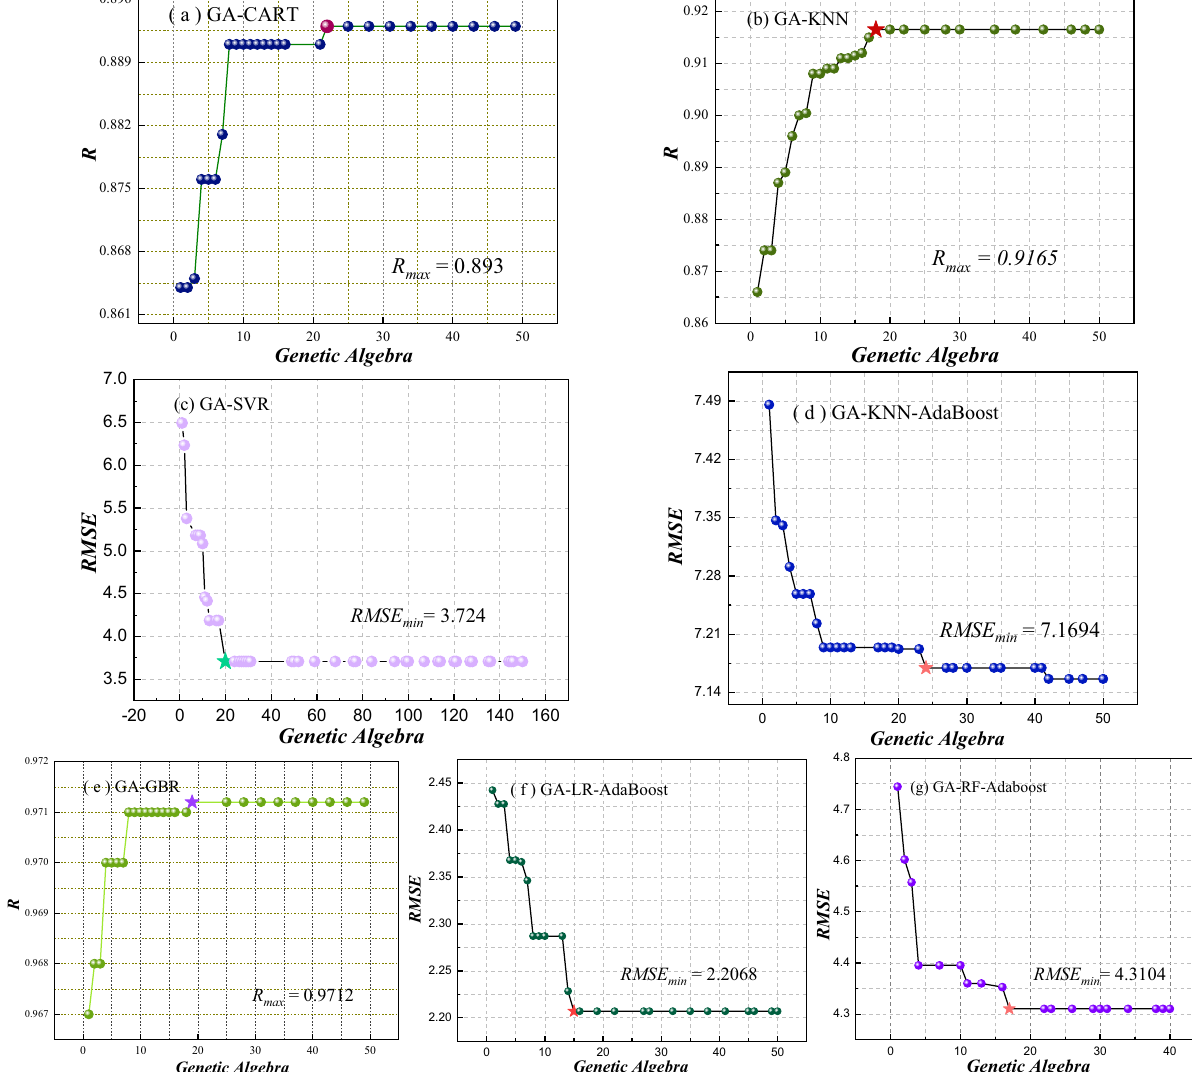
Figure 2: The procedures of variable selection in GA - learners: ( a ) GA - CART, ( b ) GA - KNN, ( c ) GA - SVR, ( d ) GA - KNN - AdaBoost, ( e ) GA - GBR, ( f ) GA - LR - AdaBoost, and ( g ) GA - RF - AdaBoost.